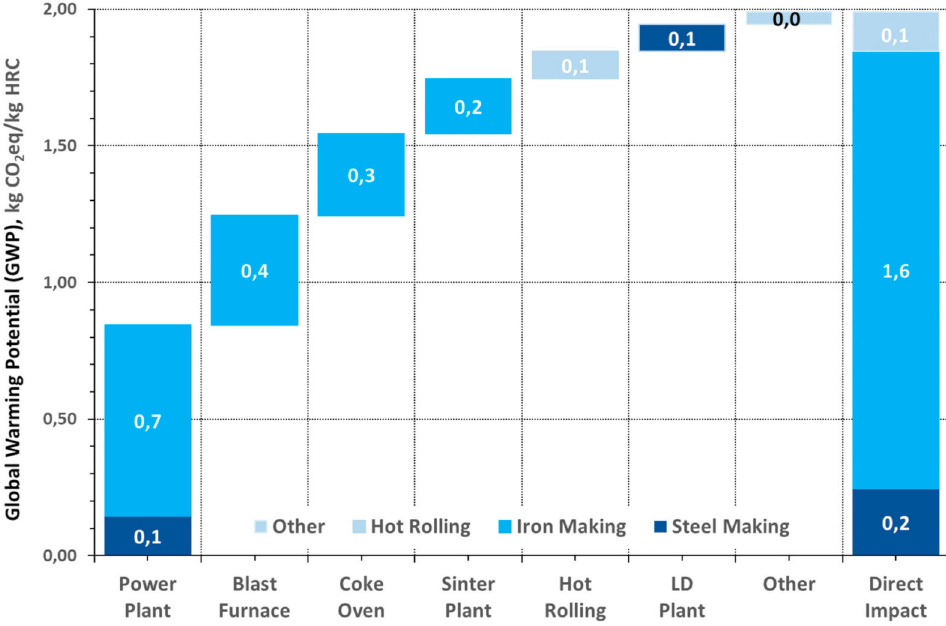
Figure 17. Carbon dioxide-equivalent (Global Warming Potential) from contemporary Integrated